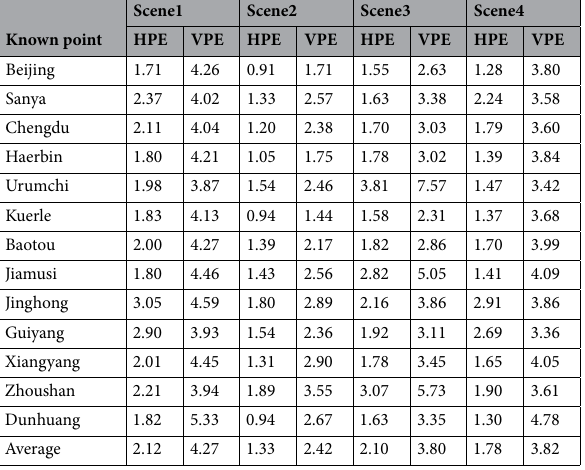
Table 6. Evaluation of the SF PE under different scenes (95%, PDOP < 6, unit: m).